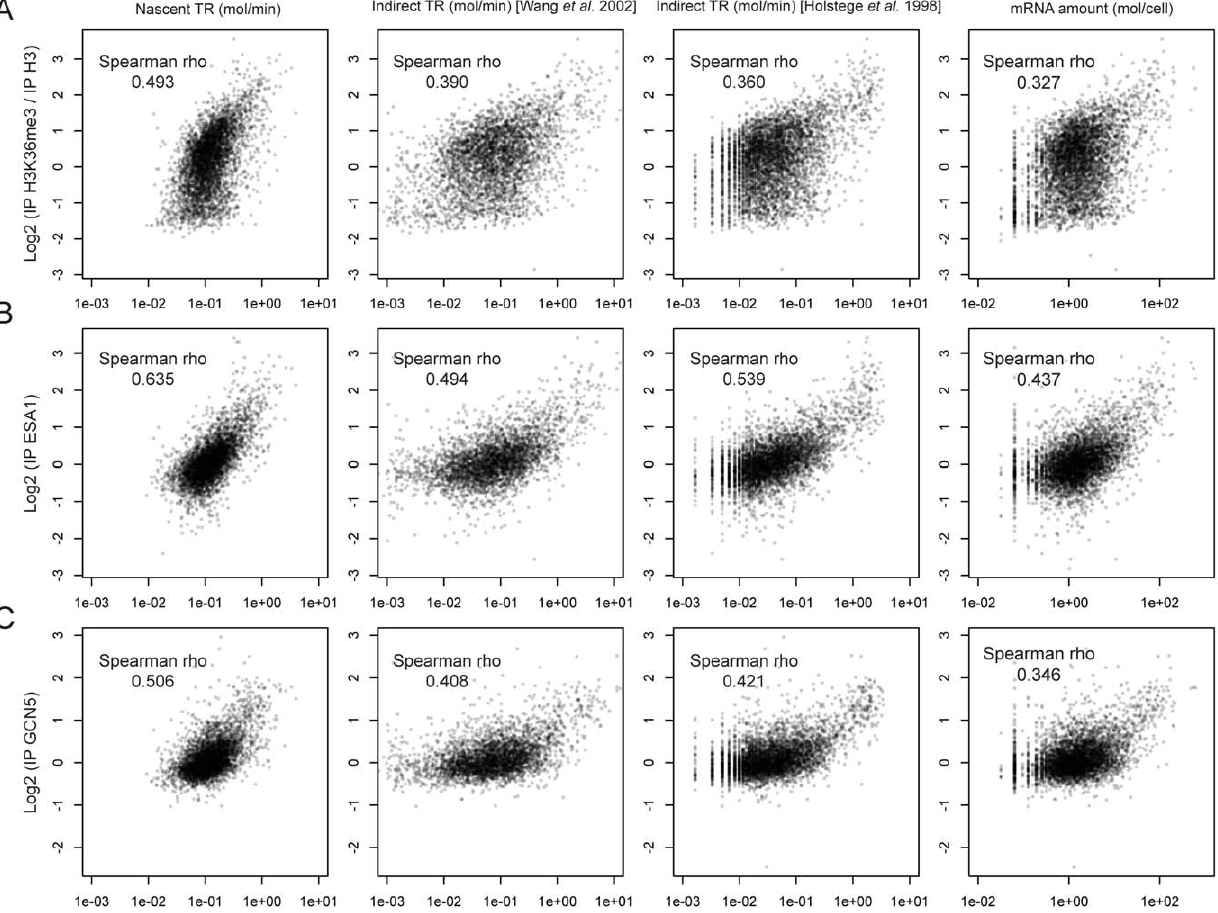
Figure 1. Comparison of the direct and indirect TR datasets with modifications related to elongation activity. Comparison of the new nascent TR dataset (this study) with a newly computed indirect TR datasets using the mRNA amount and the mRNA stability [17] that takes into account the effect of the dilution (see discussion), the indirect TR dataset from [9], and mRNA amount with different chromatin related parameters associated with active elongation as H3 trimethylation (H3K36me3, A) or presence of elongation related transcription factors the histone acetyltranferases Esa1p [27] (B) or Gcn5p (C) [25]. To avoid any bias depending on the wideness of the datasets Spearman rank correlation is used. Note that the correlations are always higher for the nascent TR dataset than for the indirect datasets, and that the indirect TR datasets show a better correlation than the mRNA amount data set.